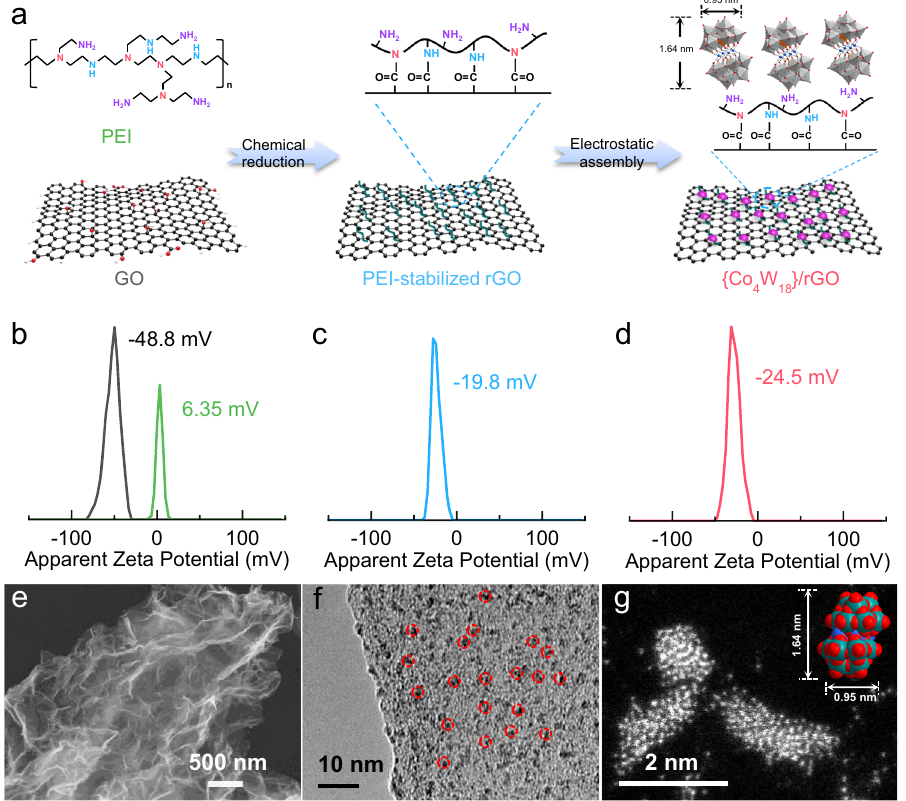
Fig. 1 Preparation and characterization of {Co 4 W 18 }/rGO. a Schematic diagram of the synthesis of {Co 4 W 18 }/rGO materials. b – d Apparent zeta potentials of GO, PEI, PEI-stabilized rGO and {Co 4 W 18 }/rGO. e SEM image, f HRTEM image, and g HAADF-STEM image of {Co 4 W 18 }/rGO